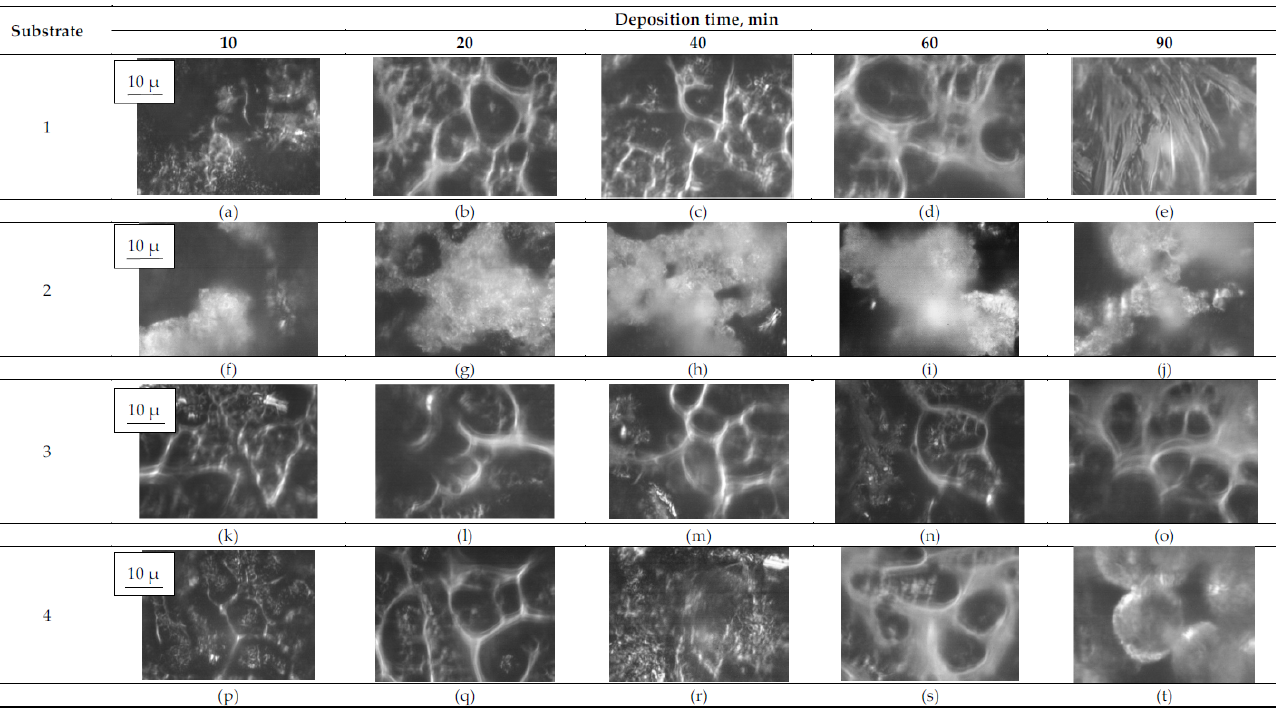
Figure 4. Optical image of clonidine on four types of substrates with different deposition times.